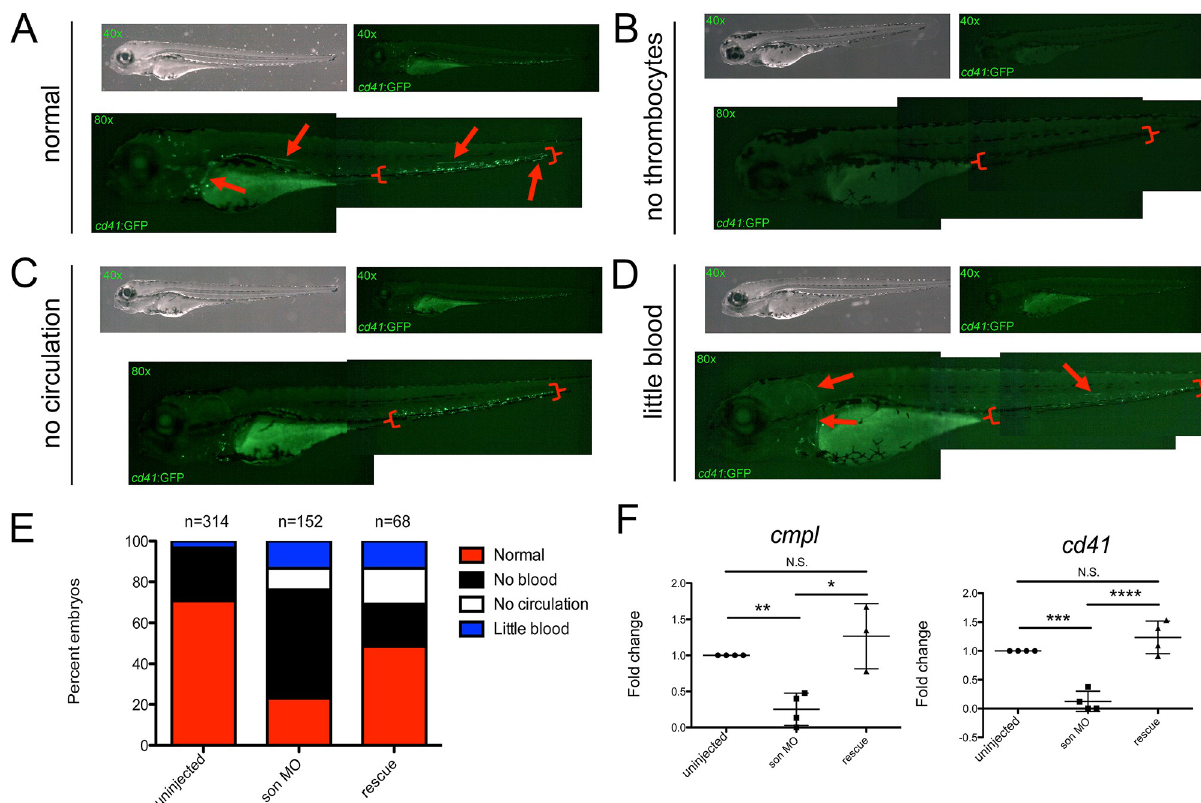
Fig 2. Reduced son expression causes a reduction in thrombocytes. Representative images of 72hpf cd41 :GFP embryos injected with son MO at the one-cell-stage of development show four common phenotypic categories associated with MO injection. Category titles are listed to the left of each image. Brightfield images are shown in top left (40x), and fluorescent images are shown in top right (40x). Zoomed in fluorescent images are shown below (80x); each green dot in the animal is a labelled thrombocyte. Red arrows indicate fluorescent “trails” made by moving thrombocytes flowing though the vasculature. Red brackets indicate the caudal hematopoietic region where the majority of thrombocytes reside at this time. ( A ) Representative images of normal thrombocyte numbers and circulating thrombocytes. ( B ) Representative animals with no thrombocytes, ( C ) no thrombocytes circulating in the animal (no circulation), and ( D ) reduced numbers of thrombocytes, some of which are circulating (little blood). ( E ) Quantitation of phenotypes shown. Number of embryos analyzed is shown above the chart. ( F ) qRT-PCR for cmpl (left) and cd41 (right) was performed. Each point represents ten embryos randomly selected from uninjected, MO-injected ( son MO), or MO-injected with son RNA (rescue) conditions that were analyzed by qRT-PCR. Middle lines represent mean and error bars represent SD. � represents p = 0.04, �� represents p = 0.006, ��� represents p = 0.002, ���� represents p = 0.001, N.S. represents no